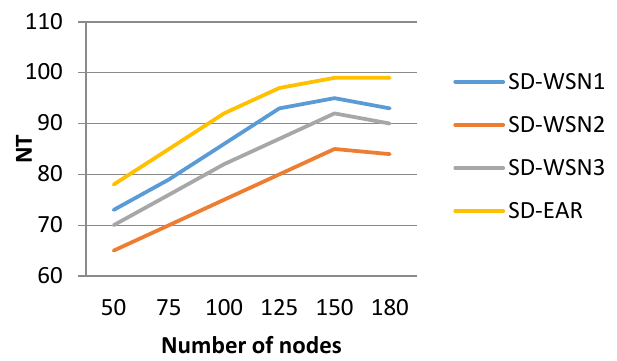
Figure 17. OEC vs. number of nodes.